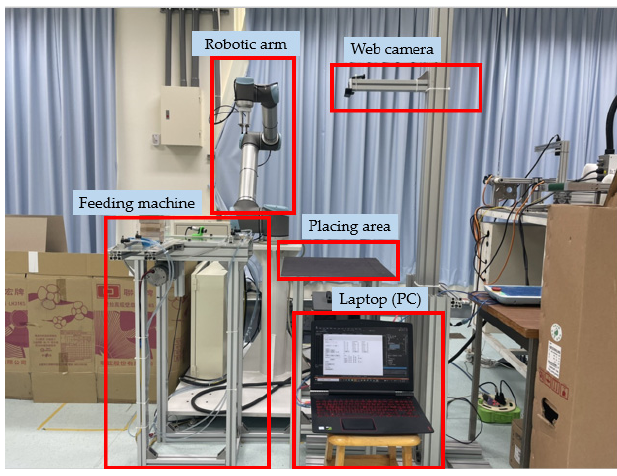
Figure 36. The workstation.